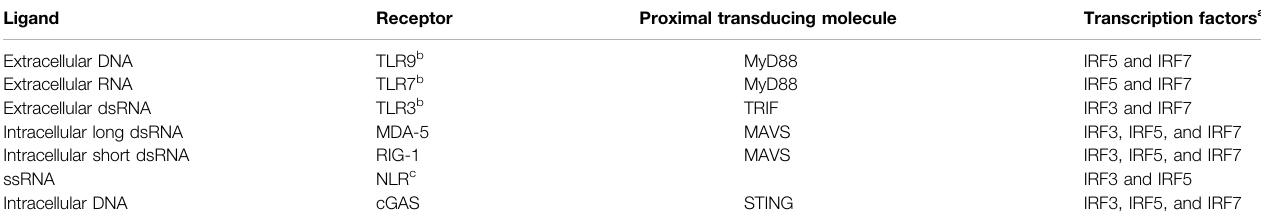
a These transcription factors work in concert with additional molecules forming transcriptional complexes. b Present in endosomes. The ligands need to be shuttled into endosomes to activate the receptors. c NLRs comprise three families of proteins: NOD (NOD1-2, NOD3/NLRC3, NOD4/NLRC5, NOD5/NLRX1, and CIITA), NLRP (NLRP1-14, also referred to as NALP), and IPAF.; Abbreviations:cGAS:cGMP-AMPsynthase;CIITA:classII,majorhistocompatibilitycomplex,transactivator;IRF:interferonregulatoryfactor;MDA5:melanomadifferentiation – associated protein 5; MAVS: mitochondrial antiviral signaling protein; MyD88: myeloma differentiation primary response 88; NLRs: nucleotide-binding oligomerization domain-like receptors; NLRP: nucleotide-binding oligomerization domain, leucine-rich repeat and pyrin domain containing (also abbreviated as NALP); NOD: nucleotide oligomerization domain; RIG-1: retinoic